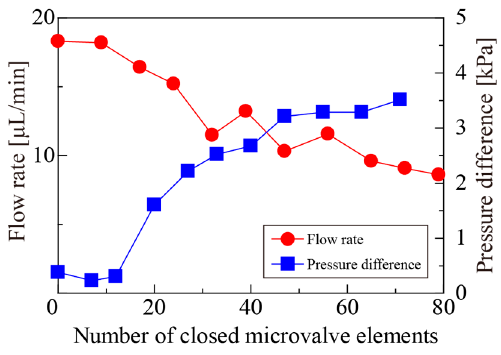
Figure 11. Evaluation results of valve properties.